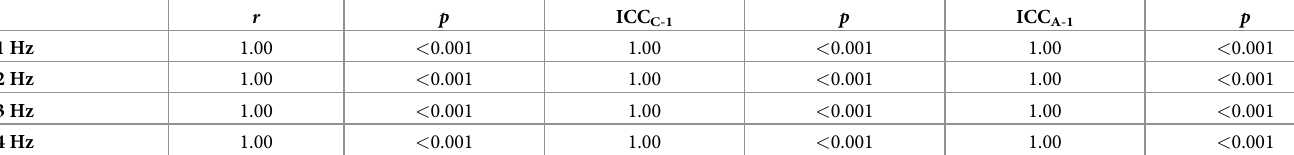
Table 5. Statistical results for correlational analyses of pose estimation vs. manual identification of heel